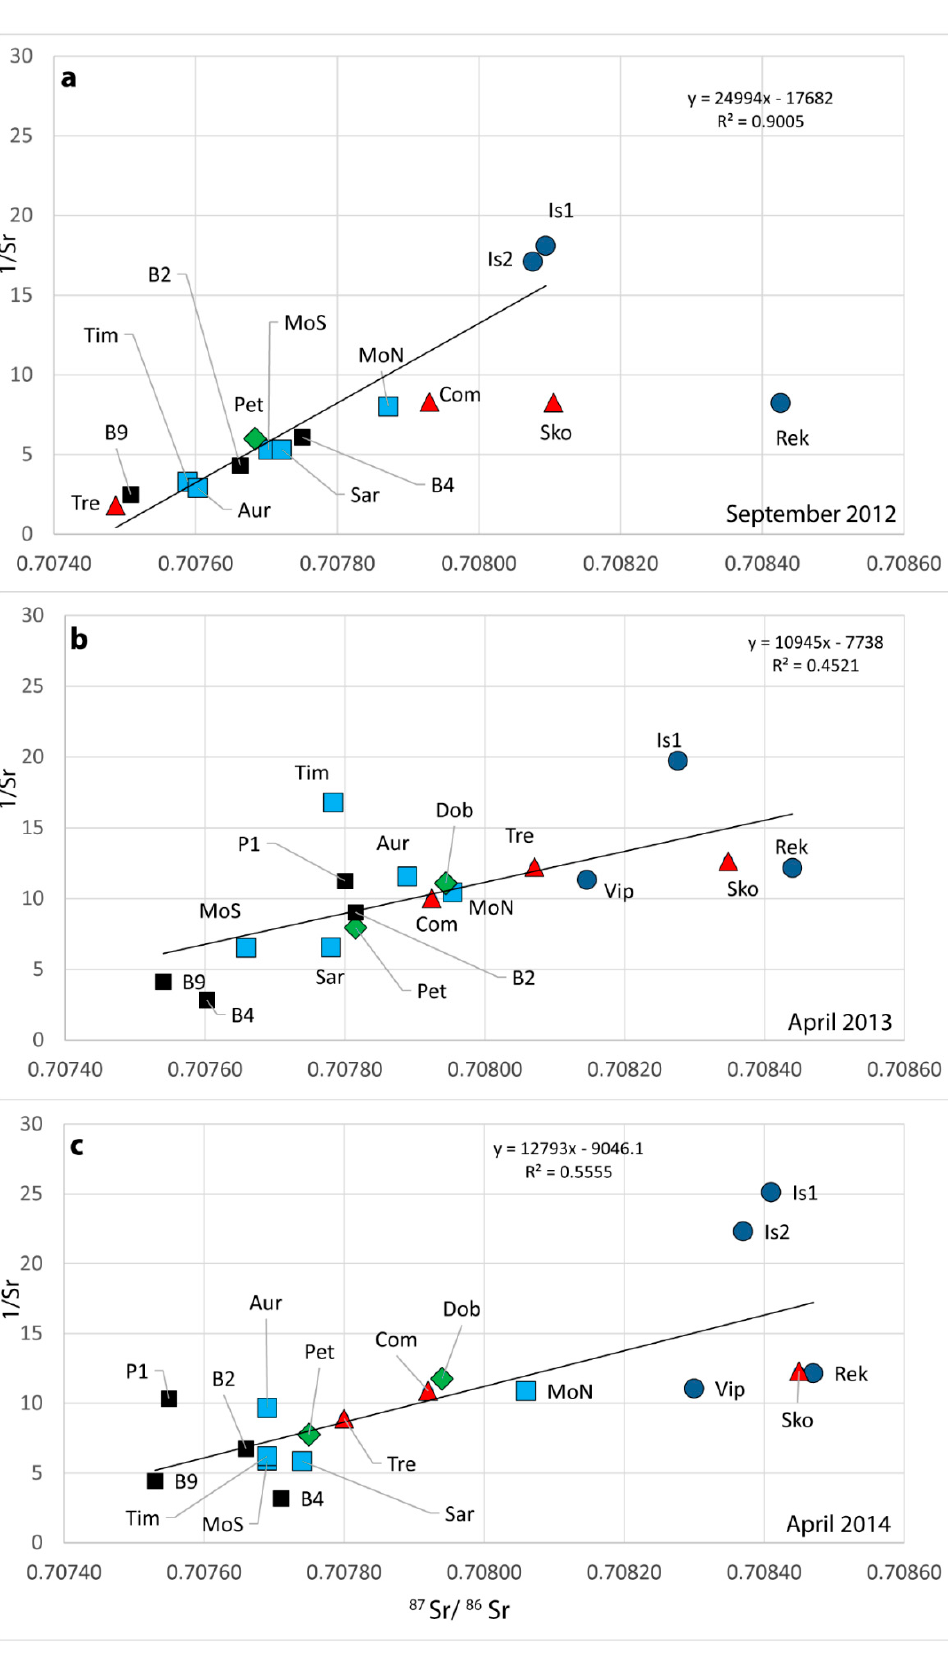
Figure 8. 87 Sr/ 86 Sr versus 1/Sr analyzed during three different water regimes: ( a ) low flow; ( b ) decreasing limb of a high flood; ( c ) decreasing limb of a moderate flood.